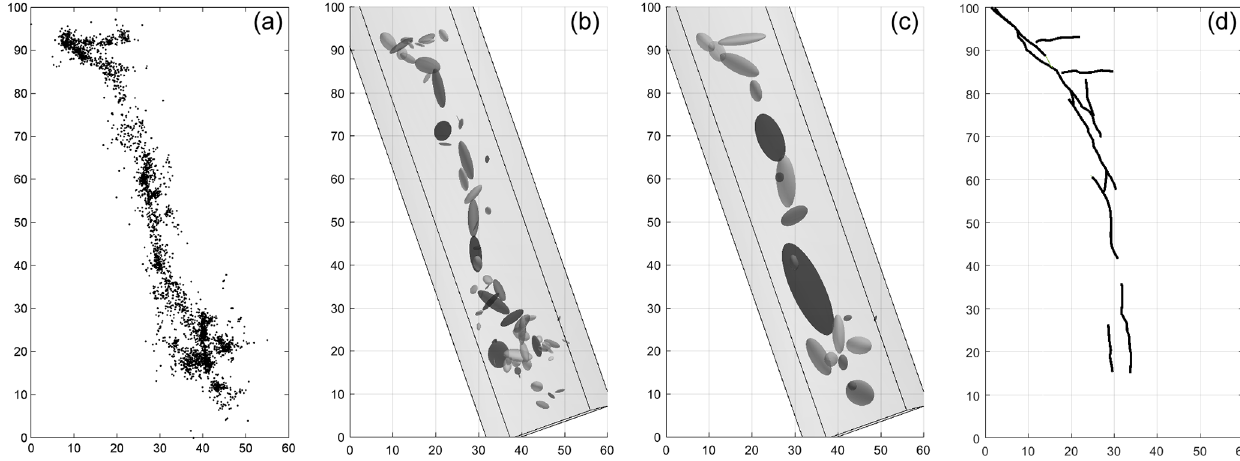
Figure 6. (a) Top view of the 1992 Landers aftershocks. Fault networks obtained from these events using the local (b) and global (c) merging criterion, each resulting in 70 and 22 clusters respectively. (d) Fault traces obtained from the Community Fault Model of southern California.